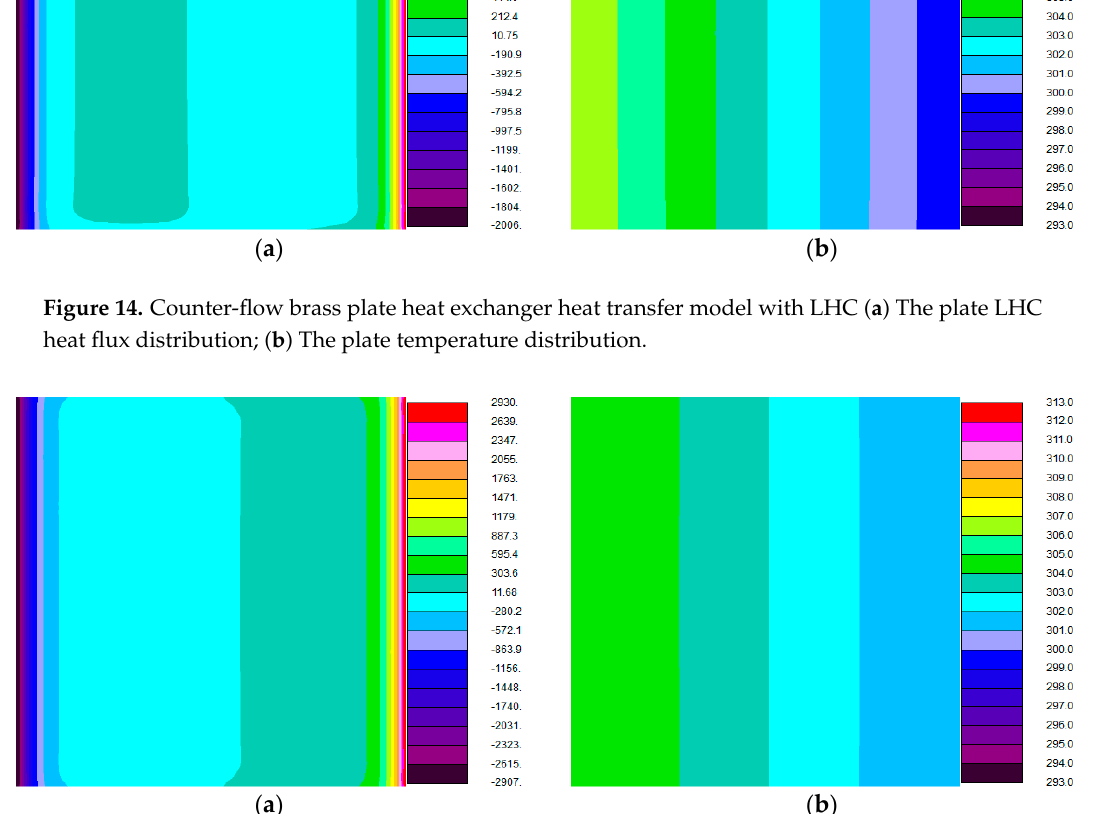
Figure 15. Counter-flow silver plate heat exchanger heat transfer model with LHC ( a ) The plate LHC heat flux distribution; ( b ) The plate temperature distribution.